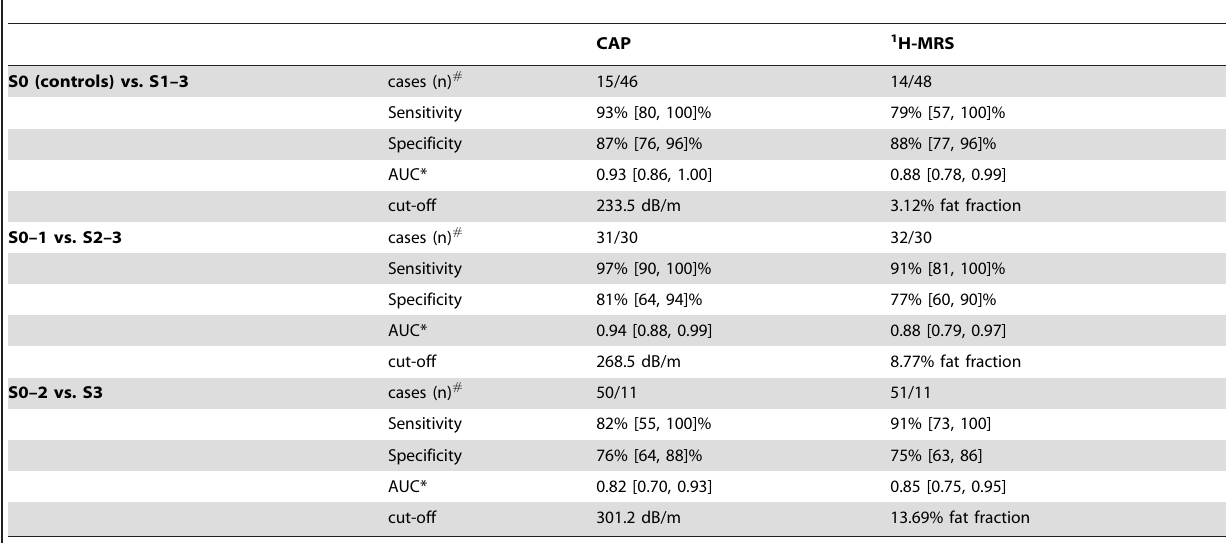
Table 3. Diagnostic performance for detection of hepatic steatosis at optimal cut-off (optimizing the Youden Index).